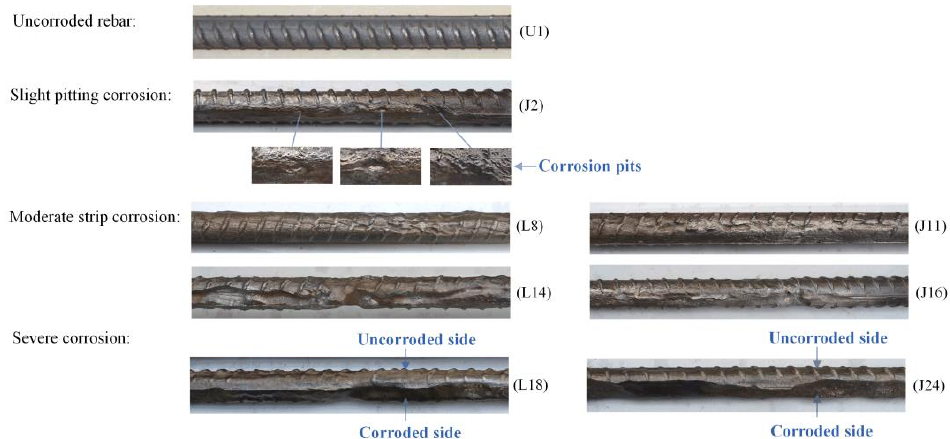
Figure 4. Corrosion patterns of rebars with different corrosion levels .